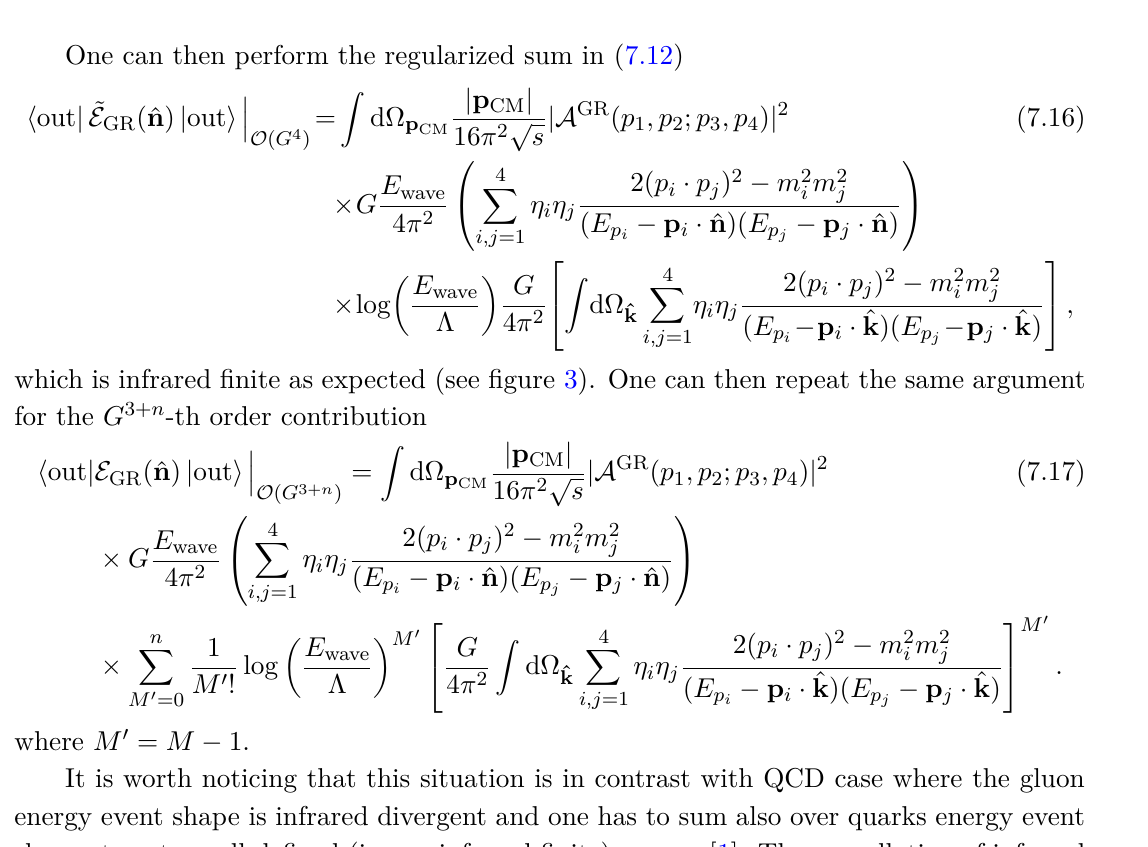
Figure 3. The picture shows how the cancellation of infrared divergences between real and virtual graviton emissions works for the gravitational energy event